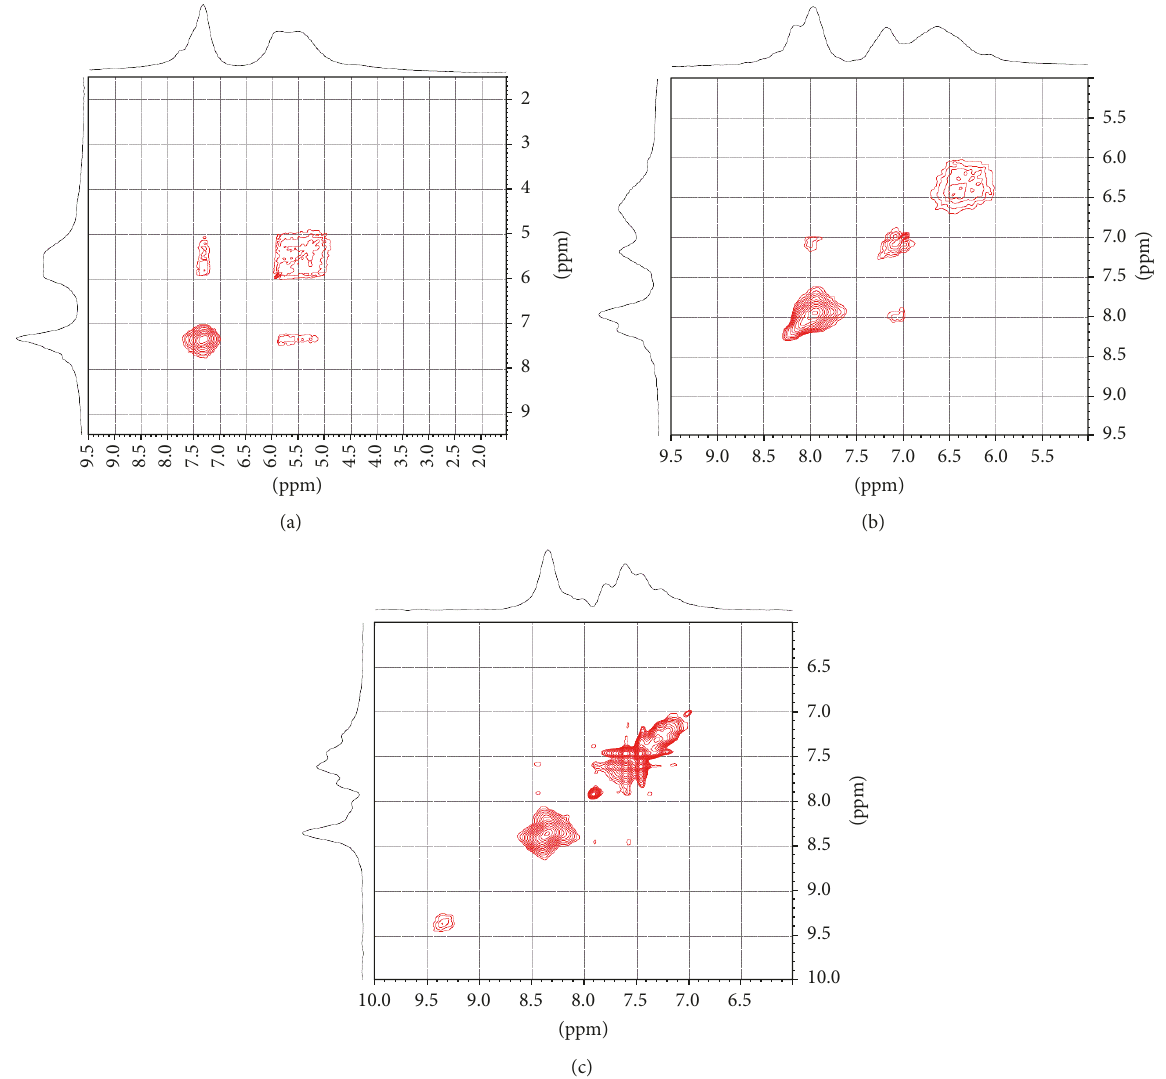
Figure 4: Two-dimensional 1 H NMR spectra of phases: (a) b 6 H 10 (NH 3 ) 2 Cl 2 , (b) (I) , and (c) (II)